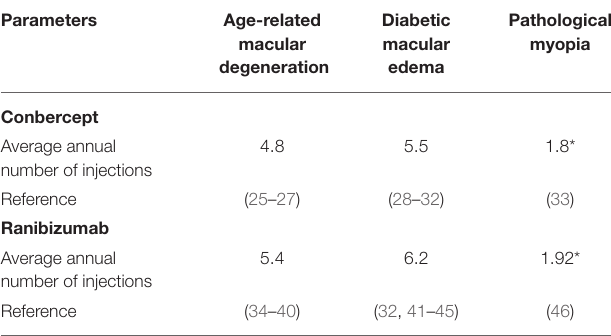
TABLE 4 | The number of injections of conbercept and ranibizumab in real-world